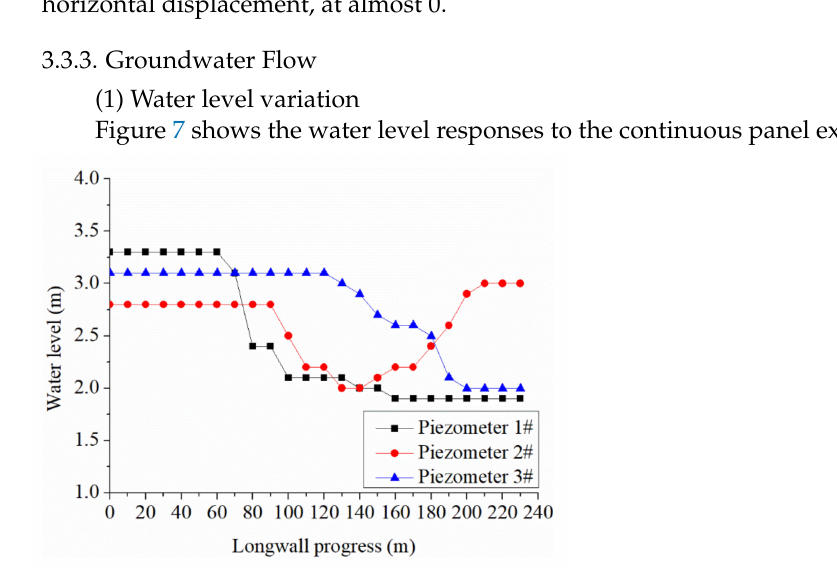
Figure 7. Water level responses to the continuous longwall